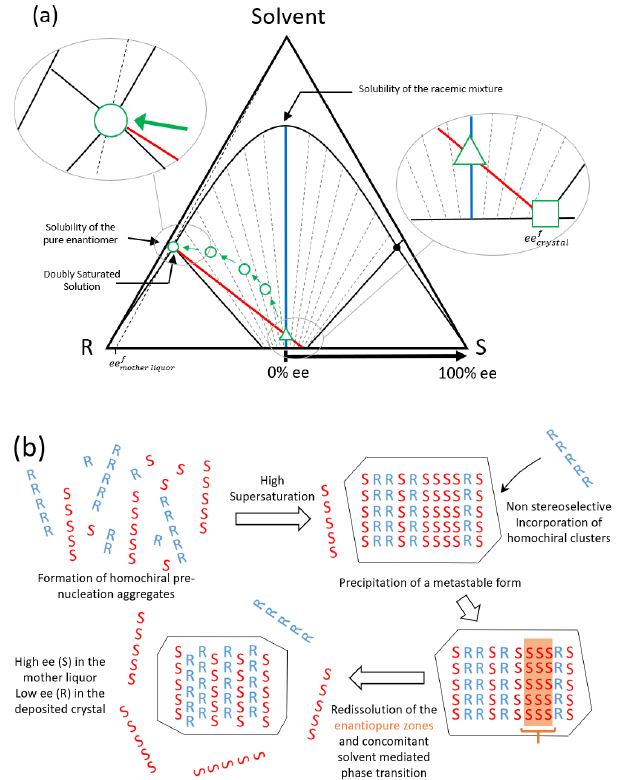
Figure 1. ( a ) Schematic representation of an isothermal section of a ternary phase diagram between a solvent and 2 enantiomers in which PE occurs (red line) as opposed to the equilibrium situation (blue line). The green triangle, circle and square stand for the overall synthetic mixture, the composition point of the liquid phase and the composition point of the crystal phase, respectively. Tie lines are the gray dashed lines and might correspond to metastable heterogeneous equilibria. ( b ) Schematic representation of the PE mechanism as proposed by Tamura et al. [16].